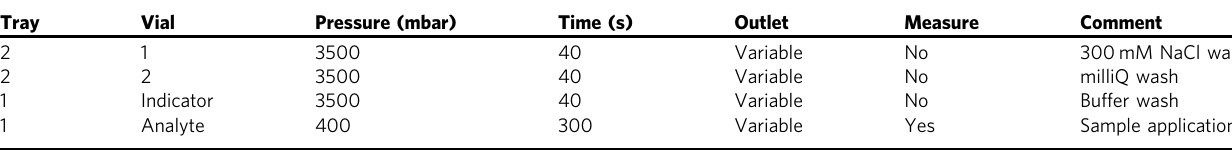
Table 2 Experimental parameters for Cap fl ex analysis of RP 3 on the FIDA 1 instrument.